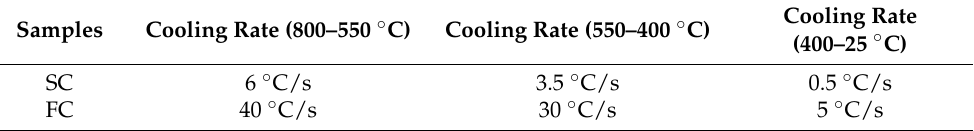
Table 2. Cooling rates of the investigated samples at different temperature ranges.